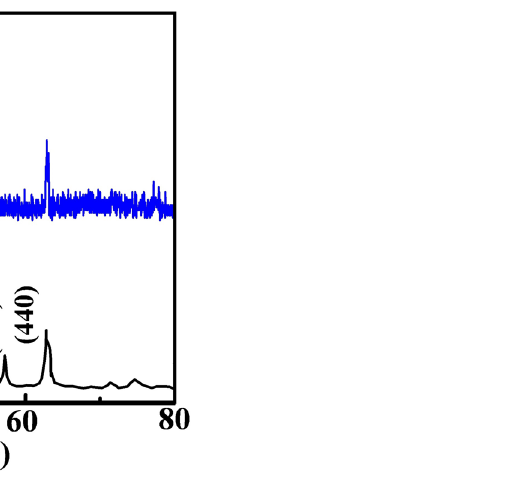
Figure 14. XRD patterns of PS and PS-Fe 3 O 4